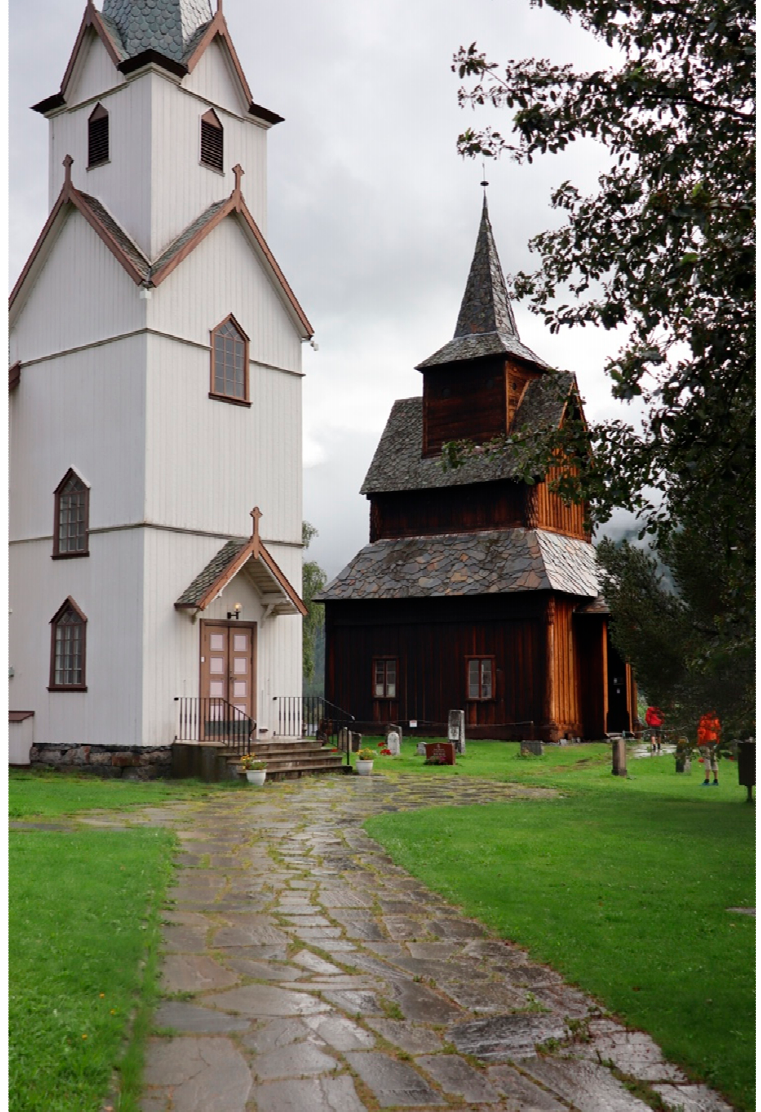
Figure 1. The wooden church of Torpo. Photo: Kaja M. H. Hagen.